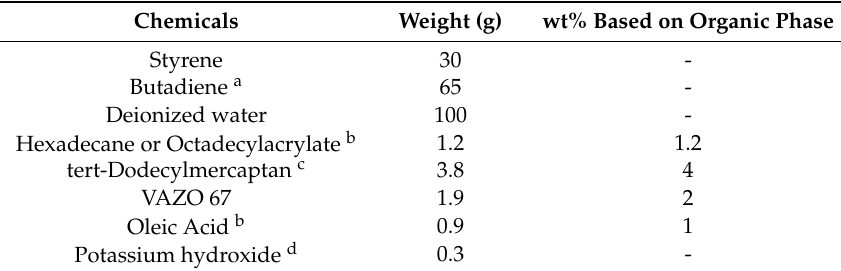
Table 2. Seeded SBR miniemulsion